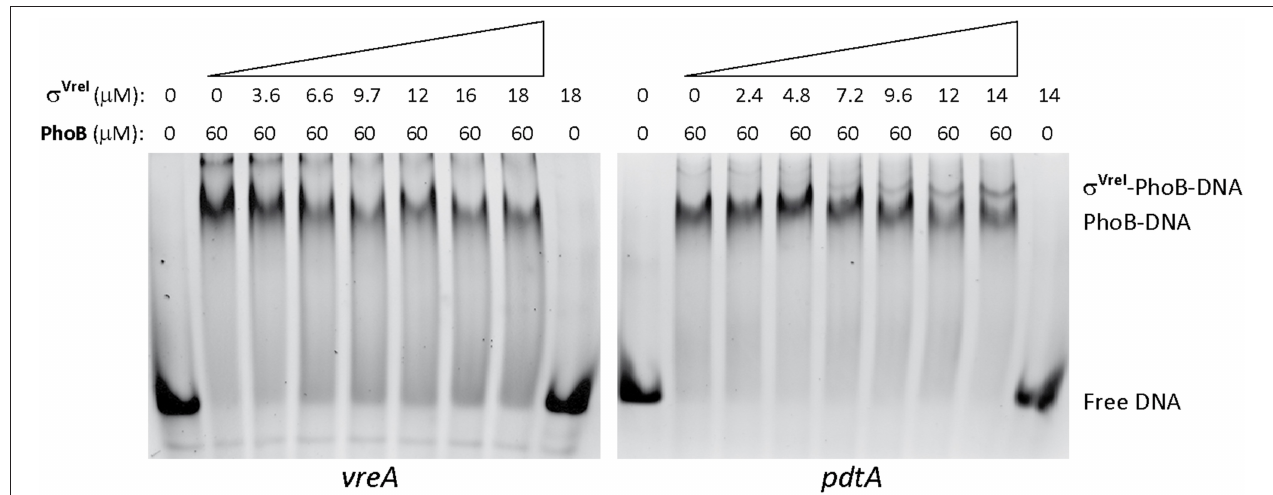
FIGURE 6 | Binding of σ VreI to the pdtA promoter. EMSA gels using fluorescein-labeled dsDNA probes containing the P. aeruginosa vreA or pdtA promoter (Table S2). Increasing amounts of σ VreI were added to a preformed PhoB-DNA complex. Upper numbers indicate the concentration of phosphorylated PhoB and σ VreI proteins used in the assay (in µ M). The position of the free DNA and of the PhoB-DNA and σ VreI -PhoB-DNA complexes are